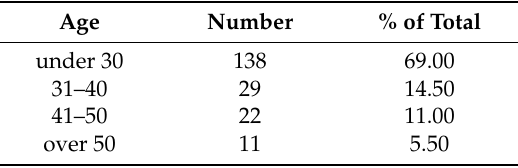
Table 3. Age structure of the sample ( N =